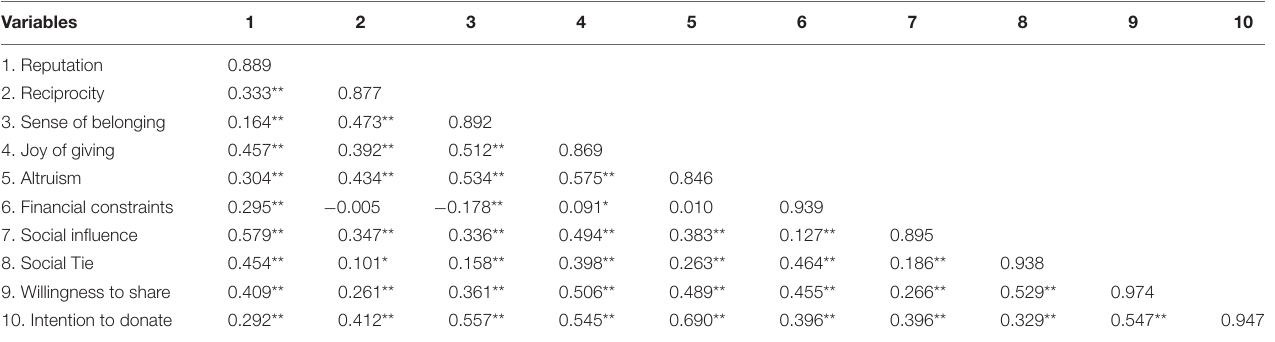
TABLE 3 | Correlations among research variables.